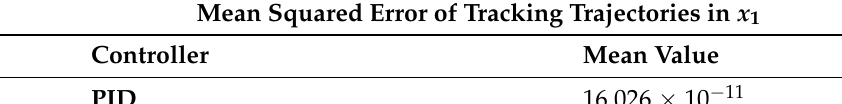
Table 2. Mean squared error in x 1 .